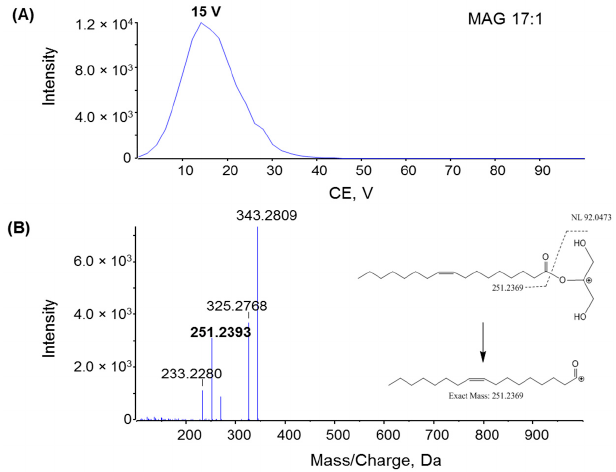
Figure 5. ( A ) Plot of intensity of fragment m / z 251.2393 of MAG 17:1 with varying rolling collision energy (CE); ( B ) MS/MS spectra for MAG 17:1 with CE = 15 V; insert: the fragmentation pathway